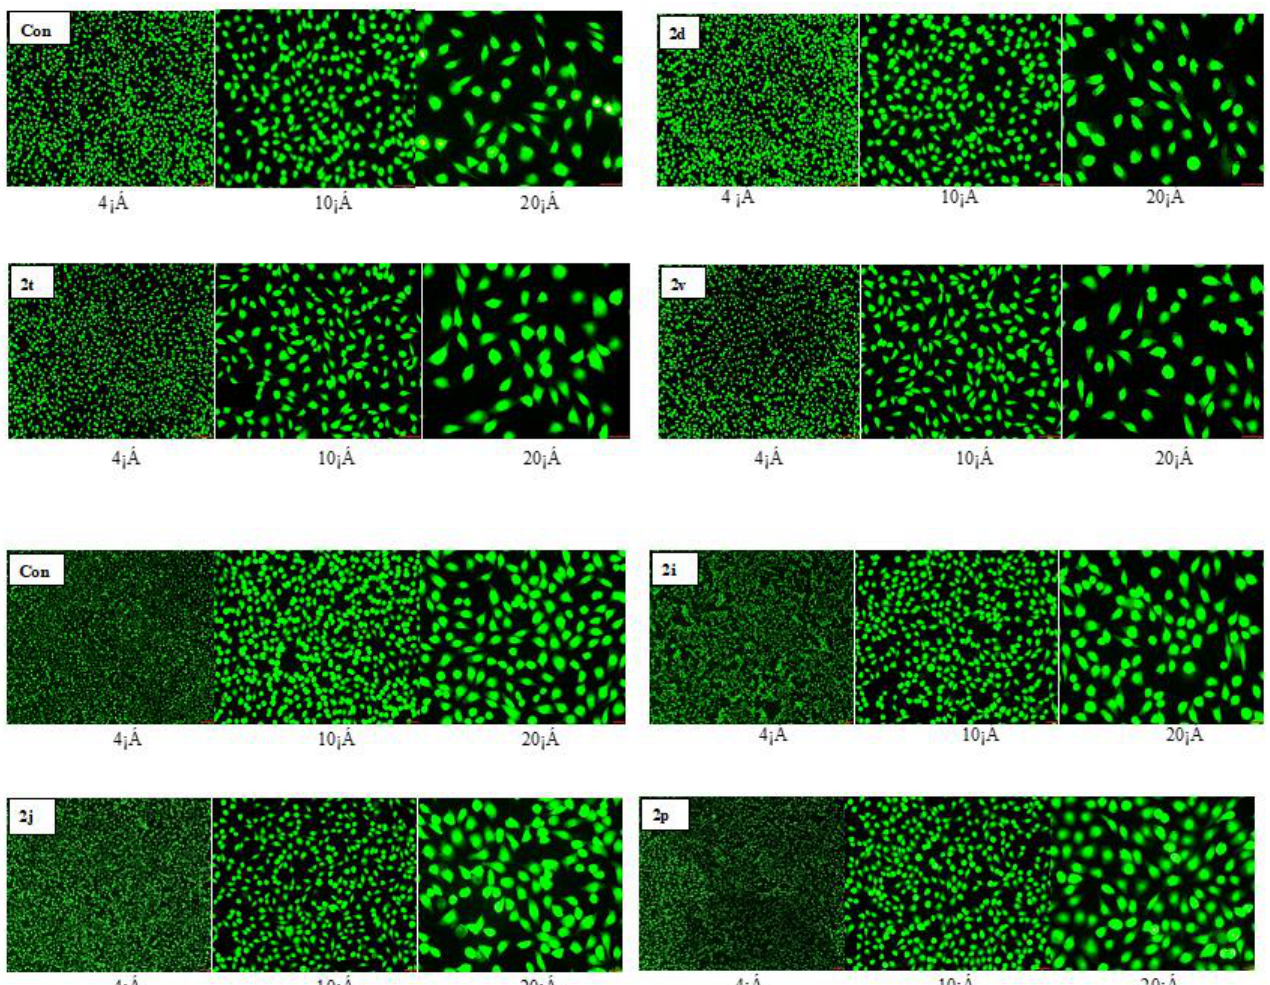
Figure 5. Cytotoxicity of 2d , 2i , 2j , 2p , 2t , and 2v on AO fluorescence staining.